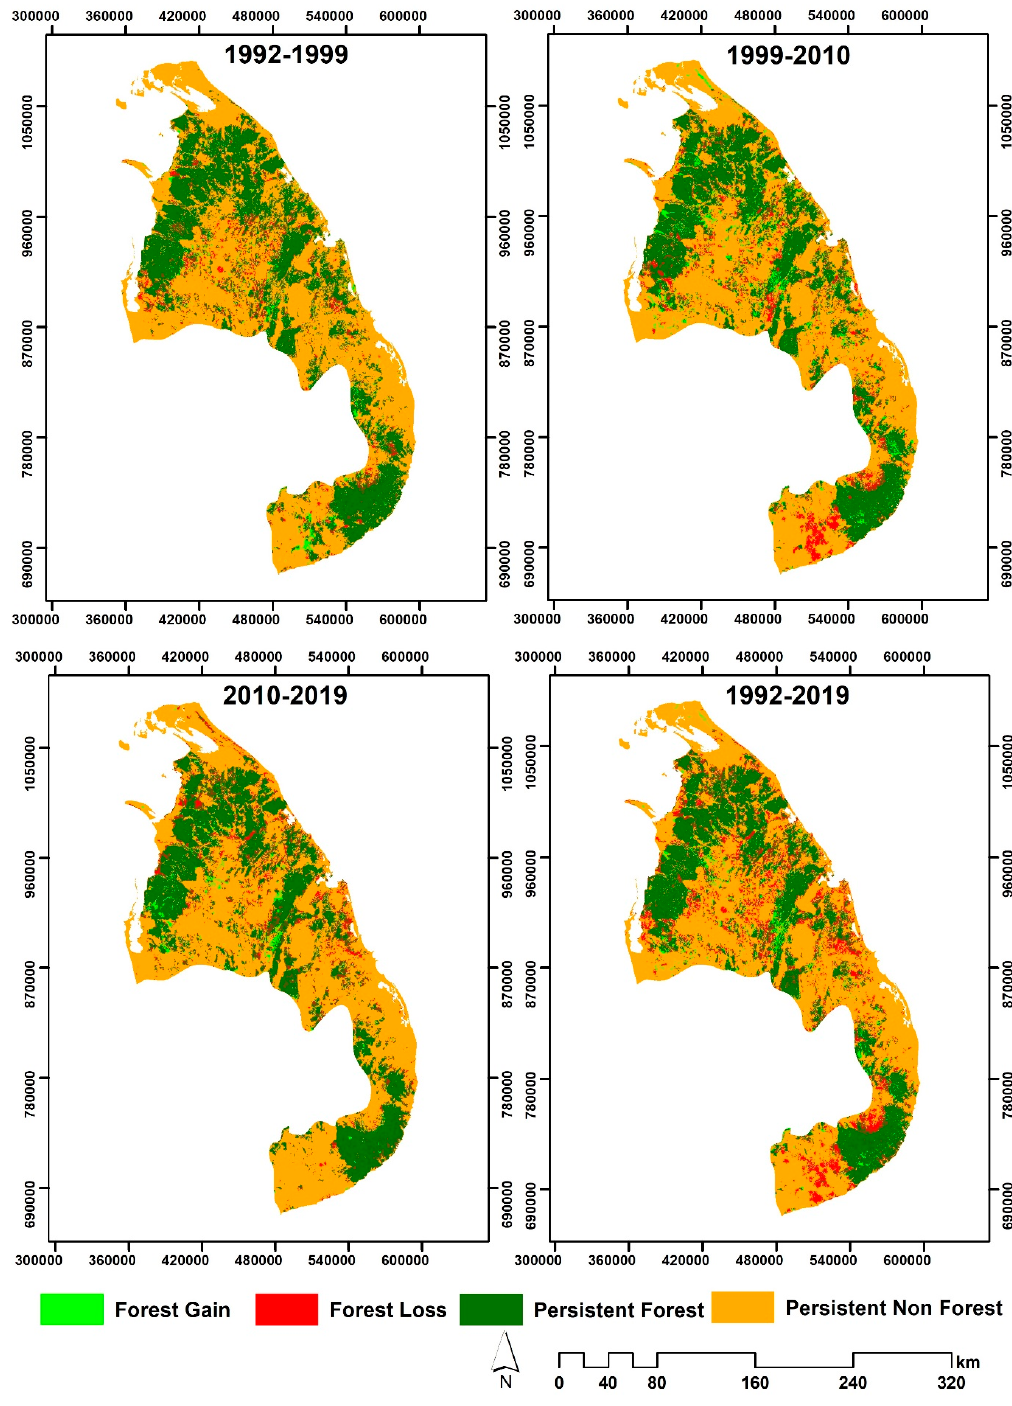
Figure 3. Forest cover changes in the DZ of Sri Lanka in three near ‐ decadal timeframes: 1992–1999, 1999–2010, 2010–2019, and 1992–2019 with estimations on forest gains and losses, and changes in persistent forest cover.